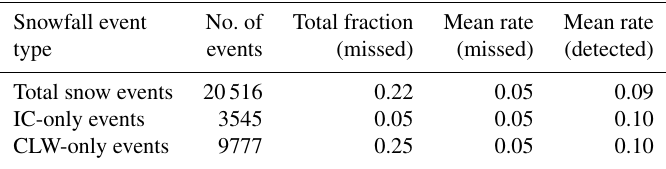
Table 1. Summary of CloudSat snowfall detection capability over Summit Station, Greenland, based on averaged MMCR data for POSS- detected snowfall. To mimic CloudSat detection we used a height range of 960–1200m, equivalent to the standard height of bin 5 of the CPR used in the 2CSP algorithm over land, and time average of 300s, which at a moderate wind speed of 5ms − 1 is equivalent to the horizontal CPR footprint of ∼